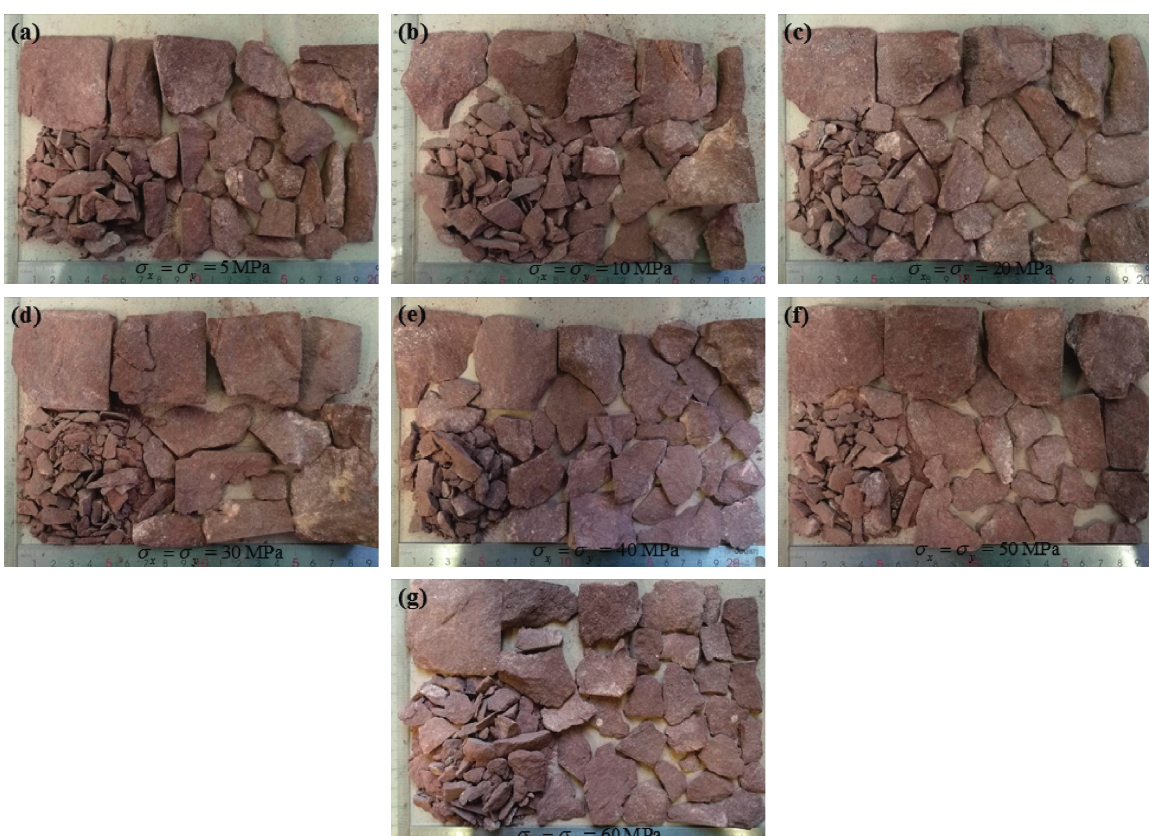
Figure 11: Failure characteristics of THU at different confining